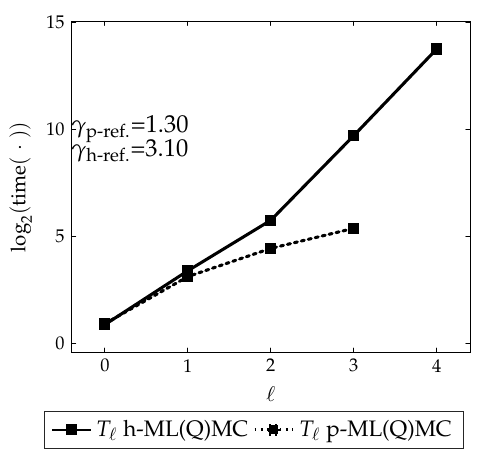
Figure 25. Times for one solve per level for model problem 2.